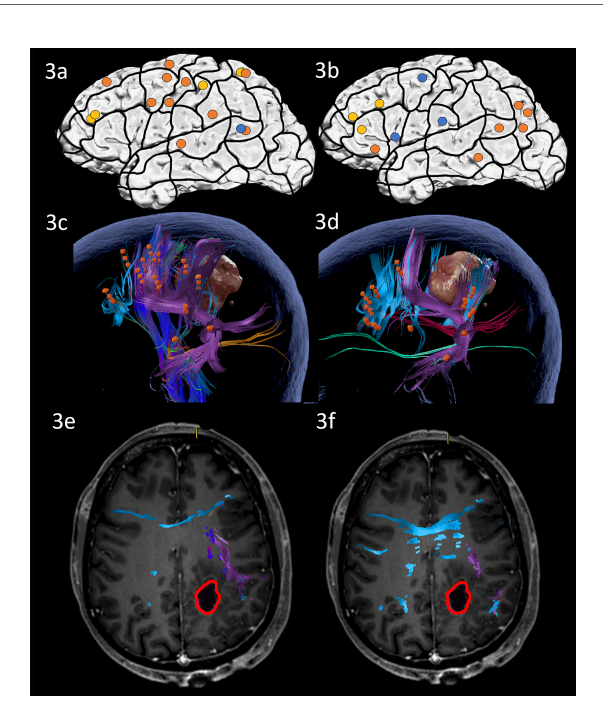
FIGURE 3 | Case 3. Left panels show ON results, right panels AN results. Panels (A, B) nTMS stimulation sites that induced errors; no response and hesitations in orange, semantic errors in yellow and performance errors in blue. Panels (C, D) Fiber tracking results including the lesion, nTMS cortical endpoints in orange and color-coded tracts with CNT in direction-coded, here dark blue, AF in purple, SLF in pink, IFOF in turquoise, ILF in yellow, and CF in light blue. Panels (E, F) Overlap of tracking and postoperative T1-weighted imaging after elastic with the resection cavity marked in